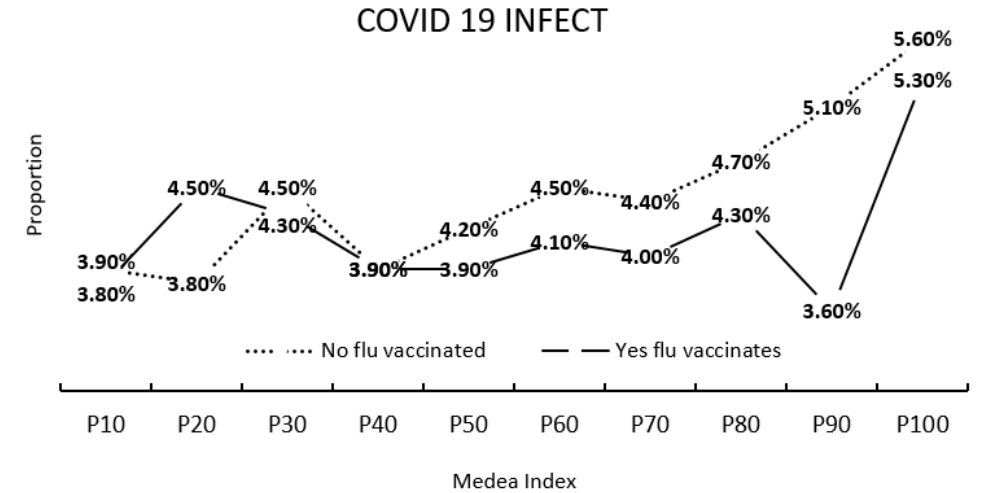
Figure 4. Proportion of people contracting COVID-19 according to whether or not they had been vaccinated against flu, and the MEDEA index.